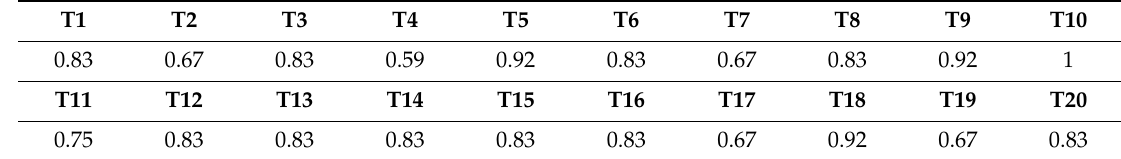
Table 5. A ff ect recognition rate of system for each video-content Trial.